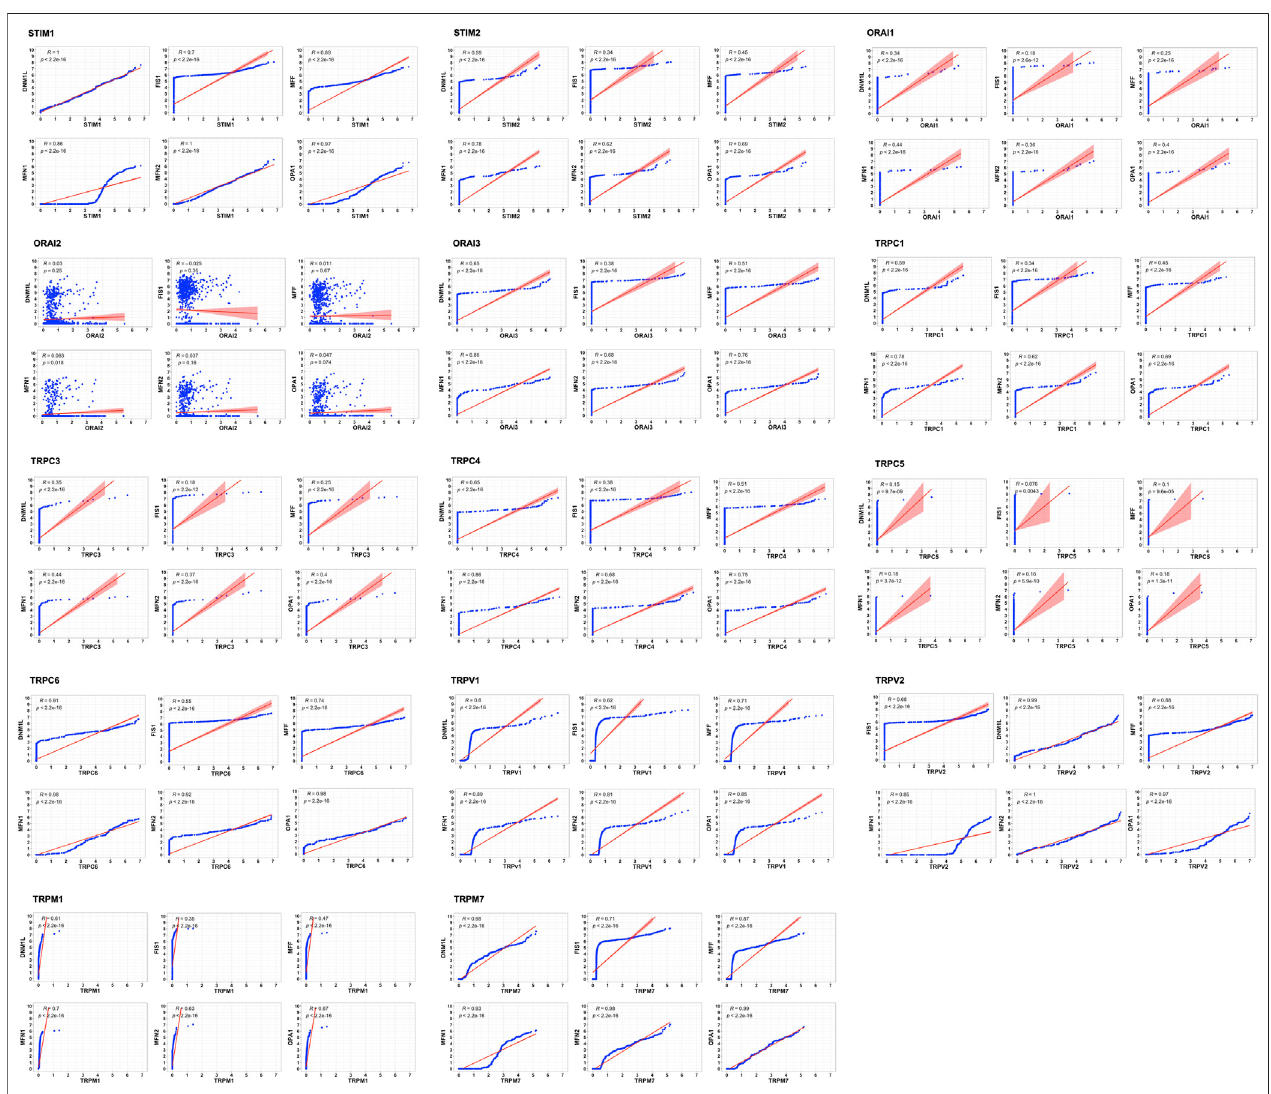
FIGURE15| CorrelationofSOCs expression withMDGs in fi broblasts acrossdataset GSE103322. Theexpression ofeach SOCs (STIM1, STIM2,ORAI1,ORAI2, ORAI3, TRPC1, TRPC3, TRPC4, TRPC5, TRPC6, TRPV1, TRPV2, TRPM1, and TRPM7) versus expression of each MDGs (DNM1L, FIS1, MFF, MFN1, MFN2, and OPA1) were compared among the fi broblasts and the correlation plots are plotted using Corr plot package of R statistical environment. TRPC7 is not expressed in the fi broblasts and is omitted. Linear regression line is shown in red color. Inset- R value (correlation coef fi cient) and p value are